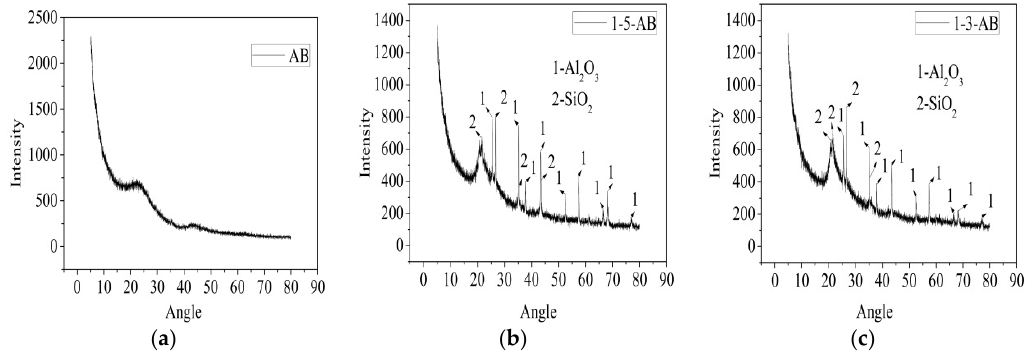
Figure 3. XRD spectra of the three biochar samples: ( a ) AB, ( b ) 1 ‐ 5 ‐ AB, and ( c ) 1 ‐ 3 ‐ AB.